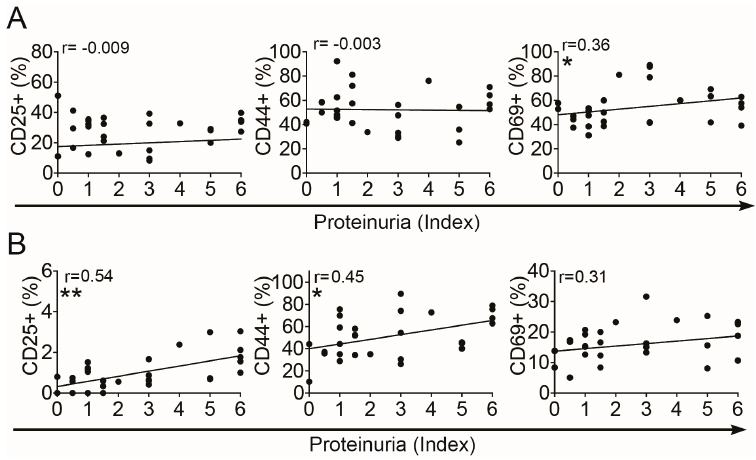
Figure 2. Phenotypic changes of intrarenal Treg and Tcon. Graphs show the percentage of CD25+, CD44hi and CD69+ cells among CD4+FoxP3+ Treg ( A ) and among CD4+FoxP3– Tcon ( B ) in correlation with the proteinuria index. Data are derived from one kidney of each mouse from two to five independent experiments ( n = 26). Correlation analyses were performed by using Spearman’s rank correlation coefficients. Black lines indicate linear regression curves using Pearson analyses (* p < 0.05 and ** p < 0.01).